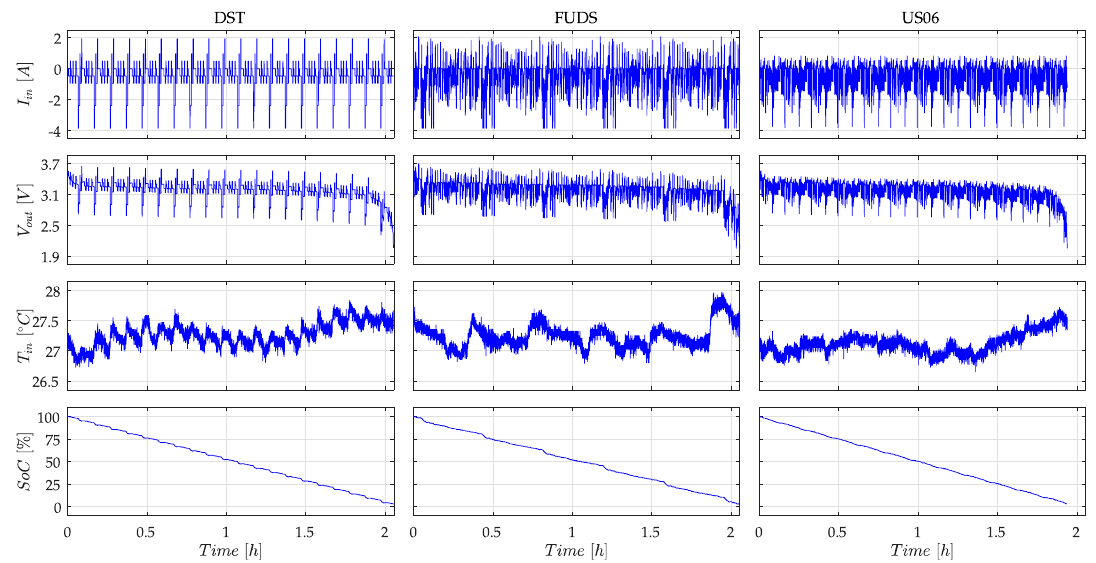
Figure 12. A123 cell time series I in , V out , T in , SoC of the dataset DST, FUDS and US06.